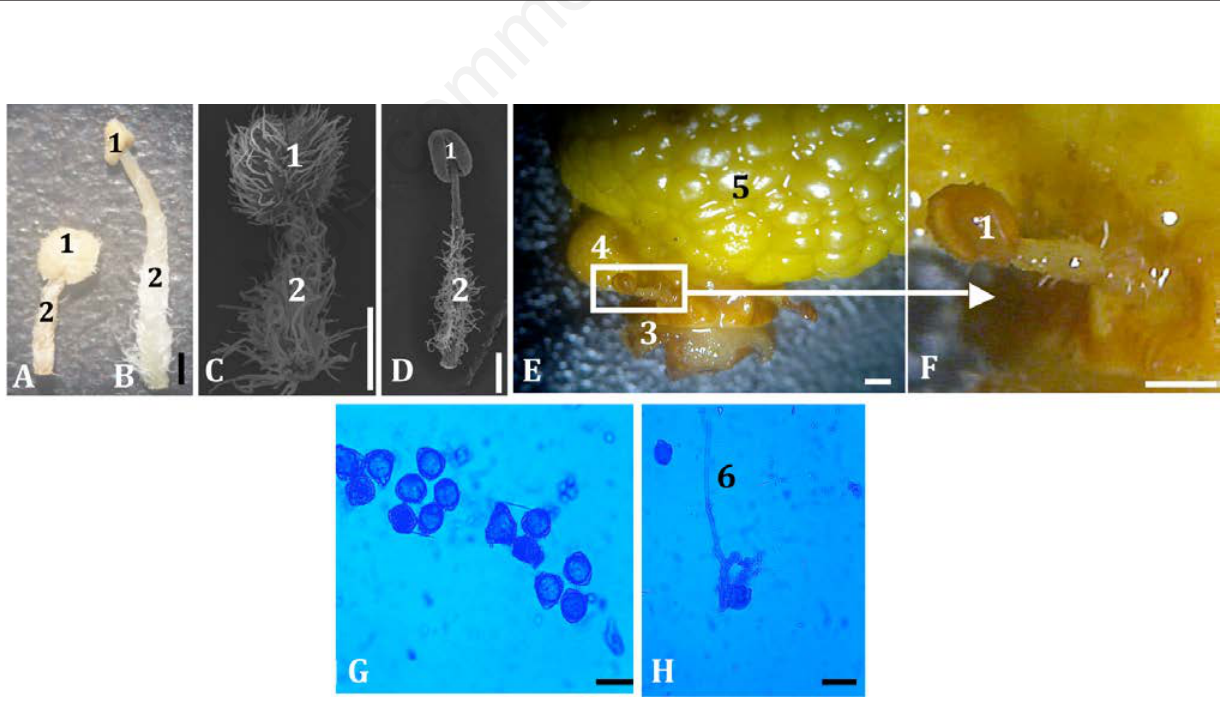
Figure 2. Pulasan flower: A) hermaphrodite; B) staminate; C) staminate, with stamen removed; D,E,G), and H) actinomorphic; F) zigo- morphic; 1: stigma 2: stylus 3: ovary 4: anther 5: filament 6: sepal 7: nectar disc 8: pistillode. Scale bar = 1 mm. A,B,D,E,F,G), and H) under binocular microscope; C) under scanning electron microscope.